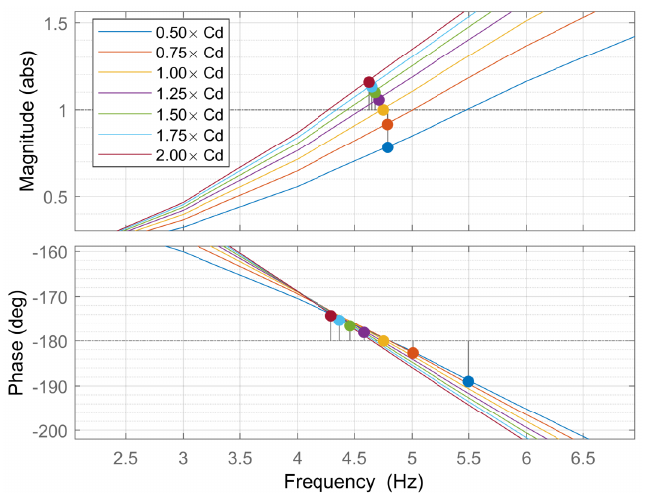
Figure 20. Bode diagram of the system eigenvalue λ 1 . Variation of DC-link capacitance while keeping the voltage controller bandwidth at 8